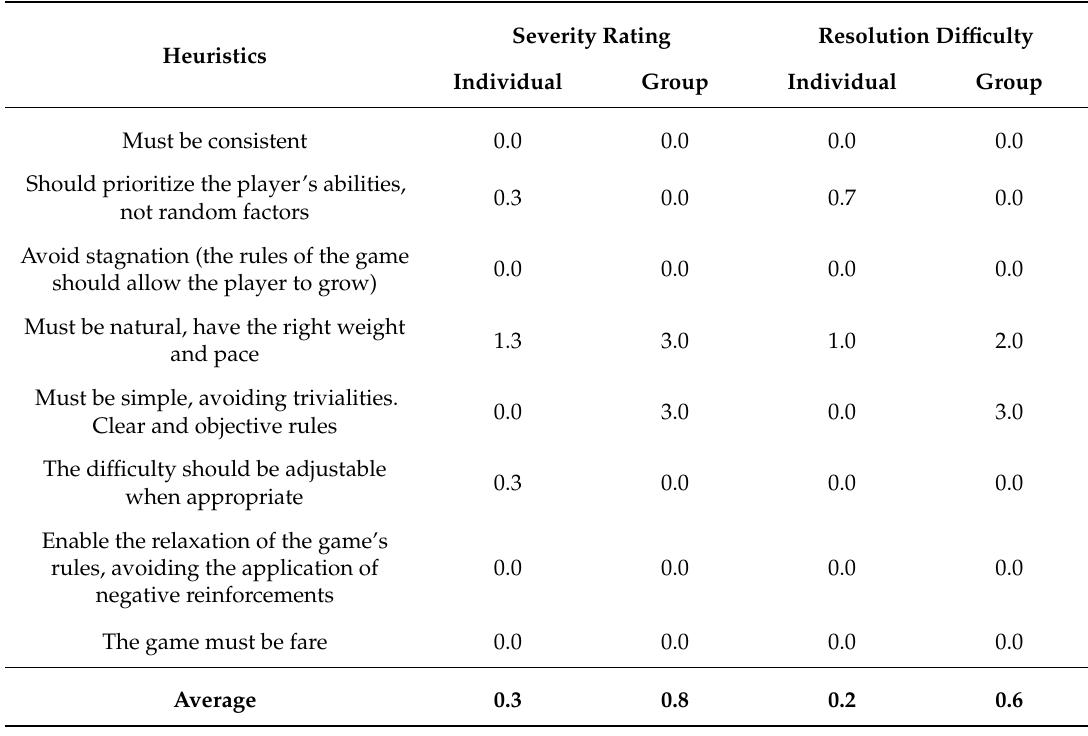
Table 2. Heuristics analysis of the game’s rules